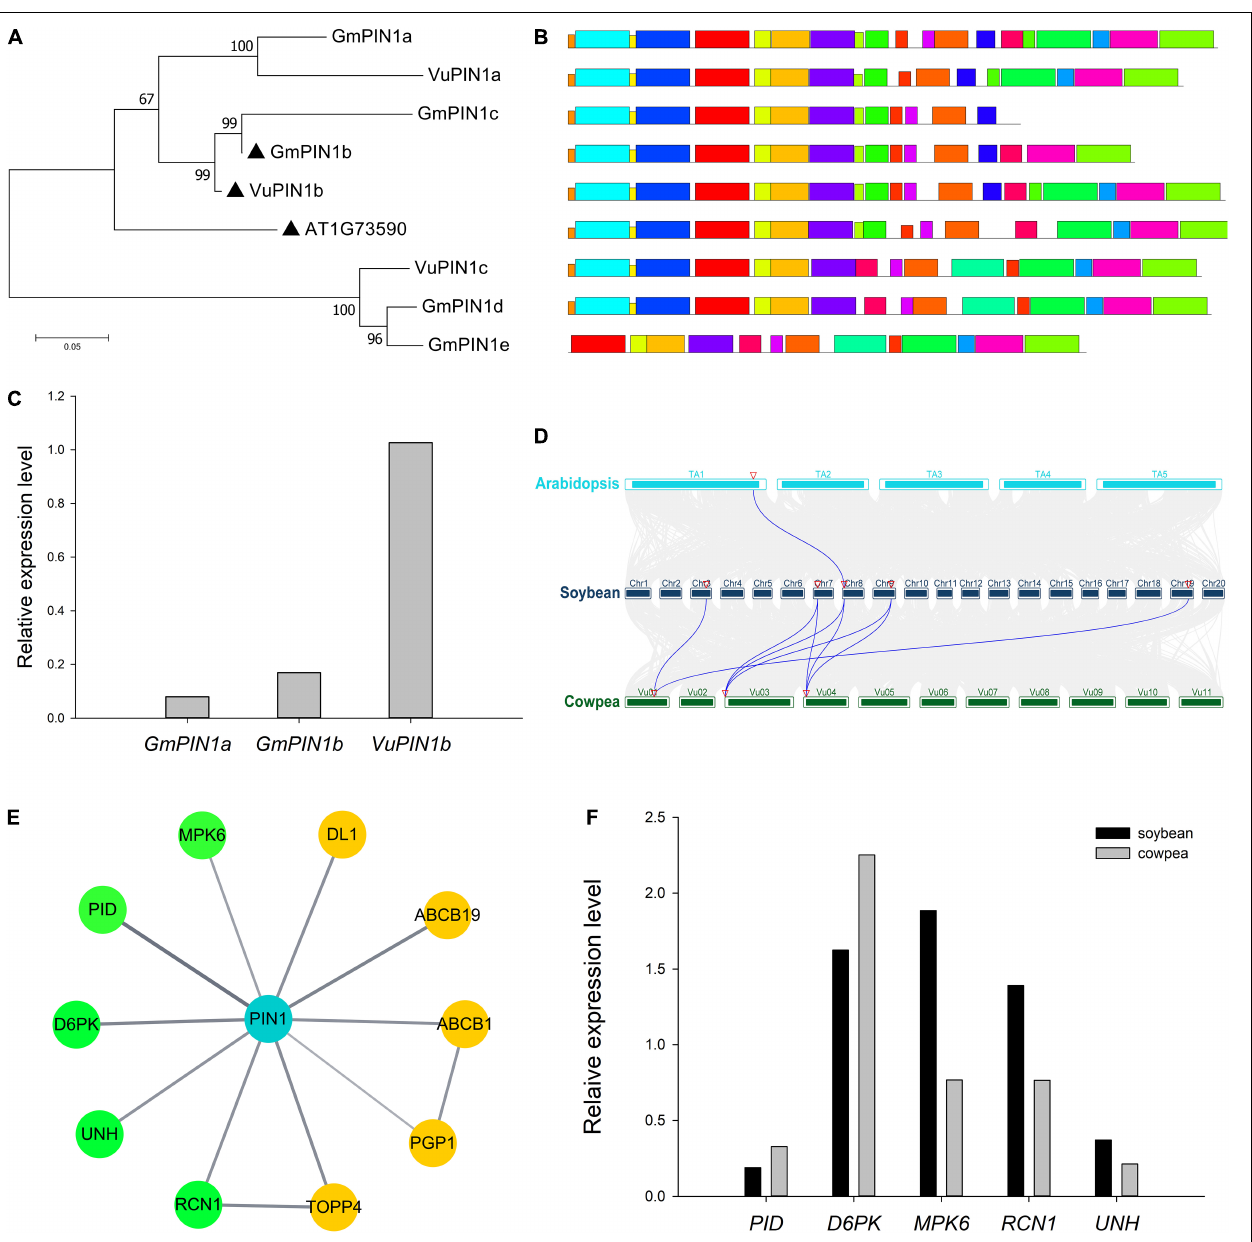
FIGURE 1 | Analysis of PIN1 and its interaction proteins in soybean and cowpea. (A) Phylogenetics tree of PIN1 gene family. (B) Motif analysis of PIN1 proteins. (C) Relative expression levels of targeted PIN1 in soybean and cowpea flowers. (D) Collinearity analysis of PIN1 gene family. (E) The network of proteins interacted with PIN1 in Arabidopsis predicted from the STRING database. The proteins with similar expression levels in soybean and cowpea were marked by yellow color, while those with significantly different expression levels in the two crops were marked by green color. (F) Comparison of the relative expression levels of genes, interacted with PIN1 , between soybean and cowpea. As described by Zhang et al. (2018), the relative expression levels was